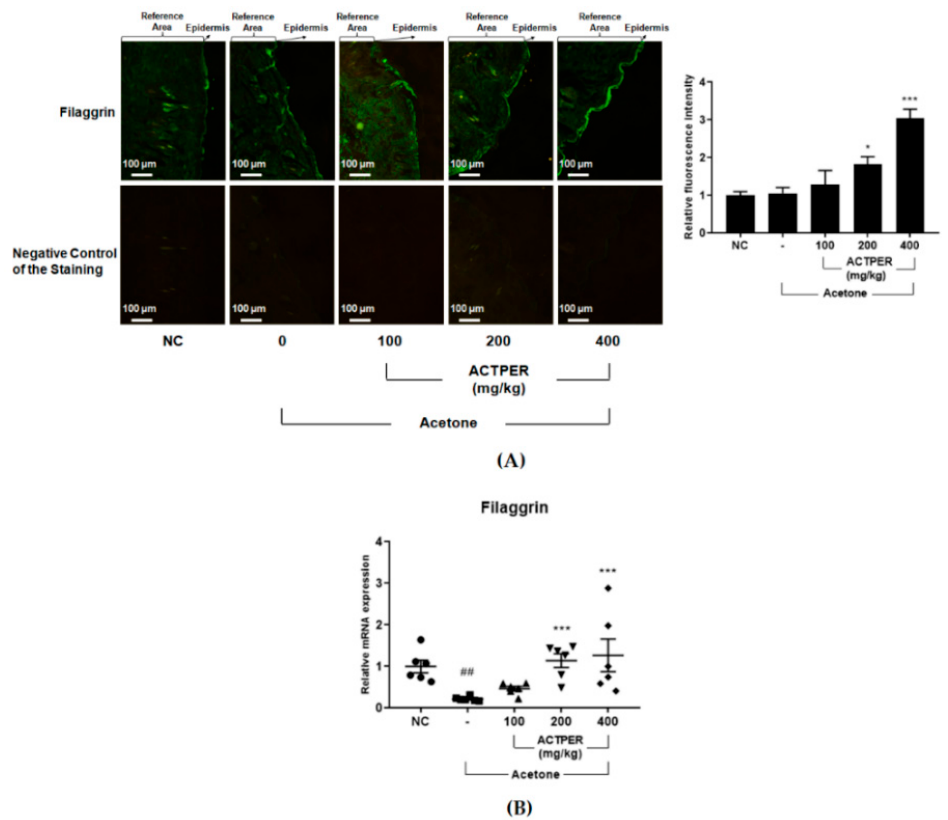
Figure 4. ACTPER promotes the expression of filament aggregating protein (filaggrin) in the acetone-treated skin of the backs of mice. ( A ) IFA staining for filaggrin in the skin of the mice’s backs; ( B ) RNA level of filaggrin in mice back skin. n = 6 per group. All data are shown as mean ± S.E.M. ## p < 0.01 compared with control group; * p < 0.05, *** p < 0.001 compared with vehicle group.